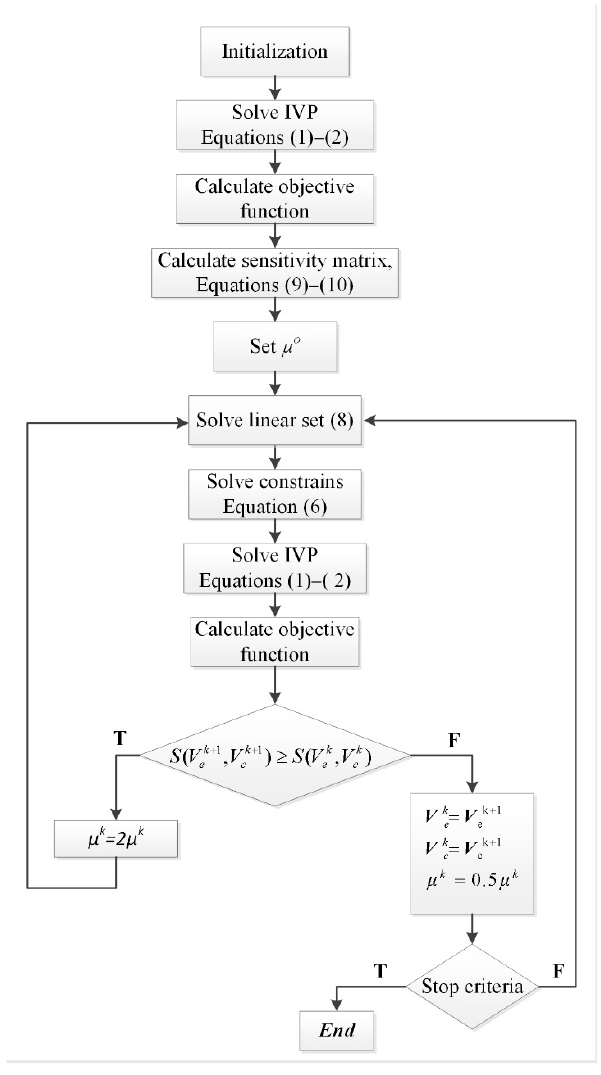
Figure 1. Solution procedure of the inverse problem.